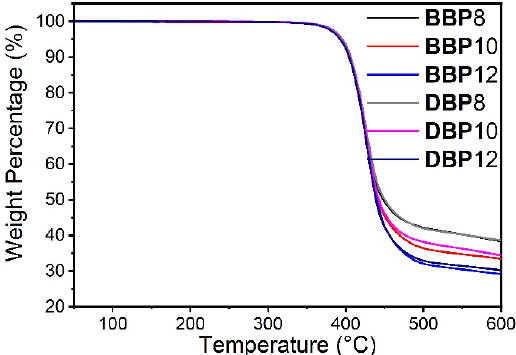
Figure 1. TGA curves for synthesized pyrene ‐ based PAHs.